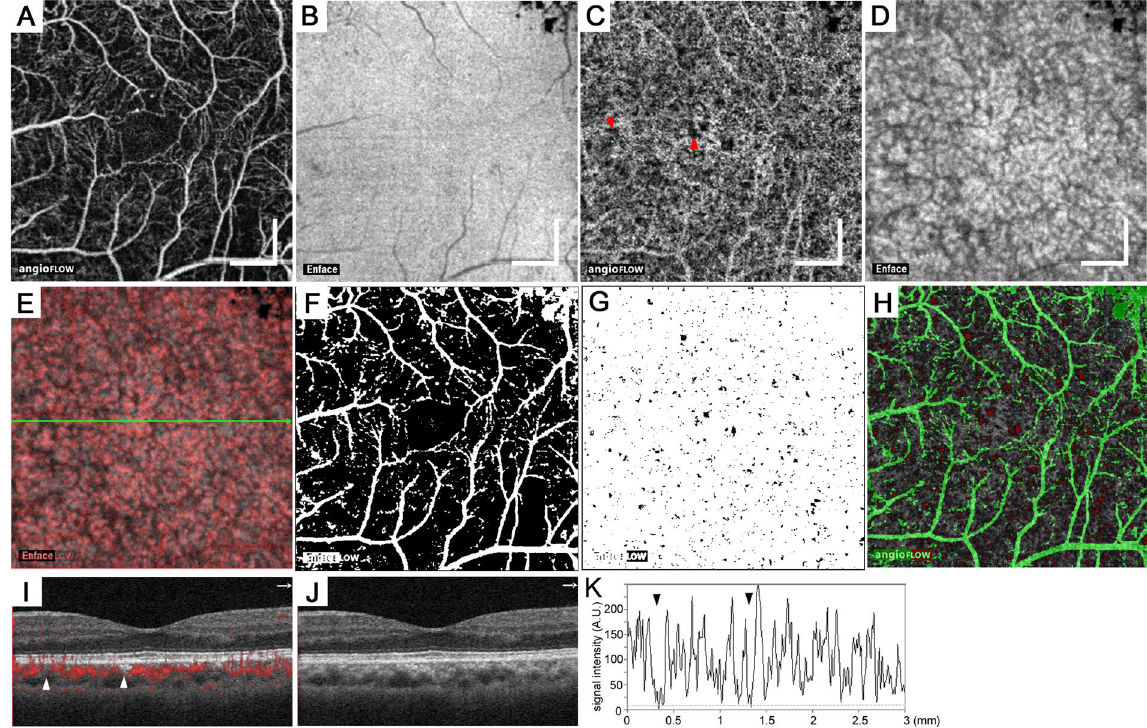
Figure 3. Spots of flow void in the choriocapillaris layer of a 53-year-old patient with severe NPDR. The en- face OCTA images in the superficial retinal layer ( A ) and the 10- μ m-thick choriocapillaris layer ( C ) and the structural OCT images in the RPE ( B ) and the choriocapillaris layer ( D ). ( E ) The merged image of panels C (red) and D (grayscale). ( F ) The en-face binary image of projection and/or shadow artifacts created from panels A and B. ( G ) The binary images of the non-flow areas (black) in the choriocapillaris layer after artifact removal. ( H ) The merged image of panel C (grayscale), ( F ) (green), and ( G ) with inverted signals (red). ( I , J ) B-scan images with and without decorrelation signals (red) along the green arrow in panel E. ( K ) The intensity of the decorrelation signals along the green arrow in panel E. The arrowheads in panels C,I, and K indicate spots of flow void. Scale bar = 500 μ